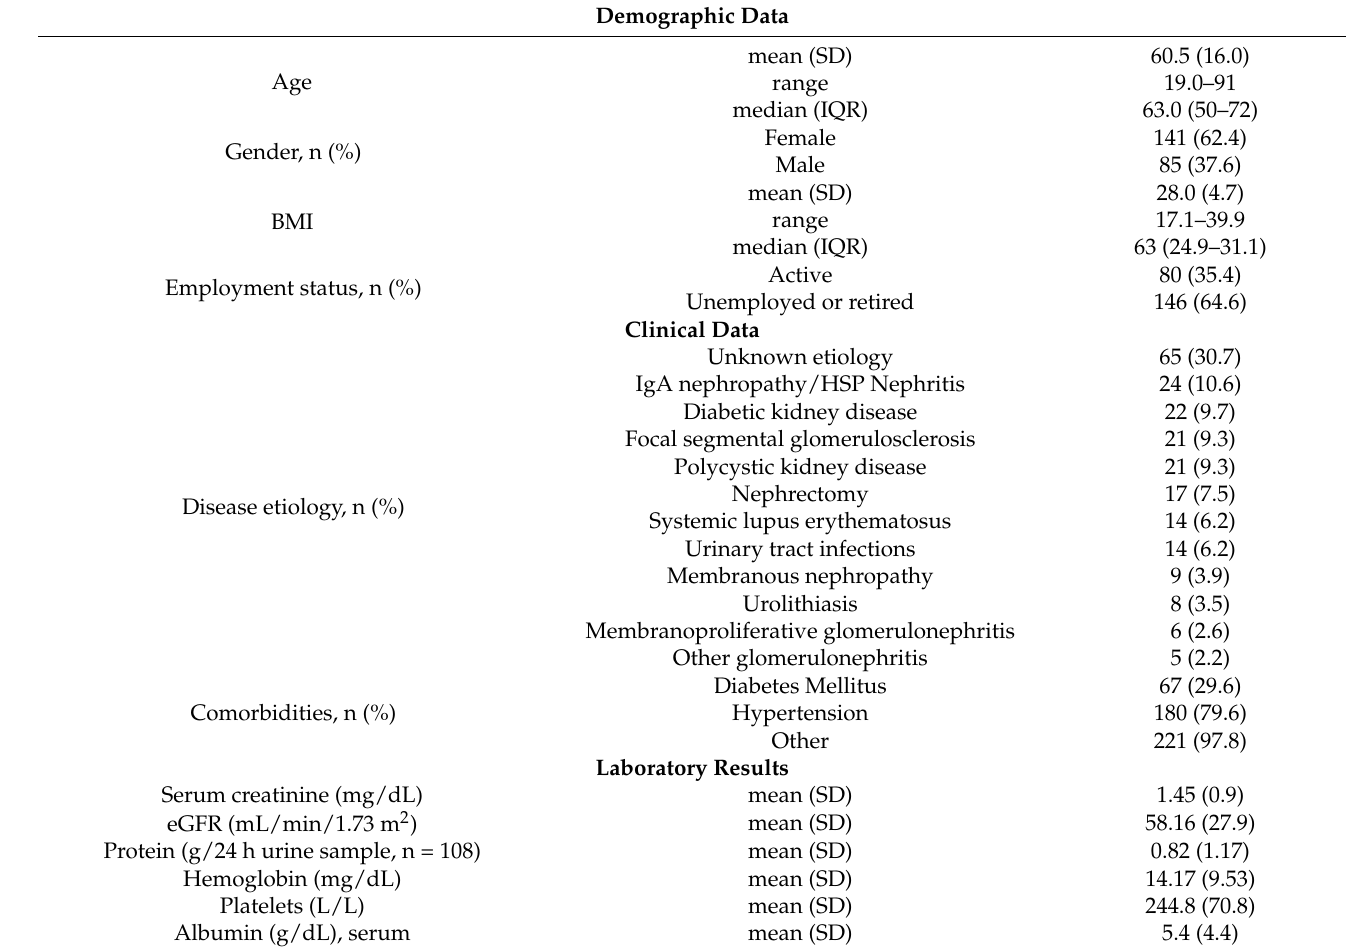
Table 1. Demographic, clinical and laboratory characteristics of the CKD